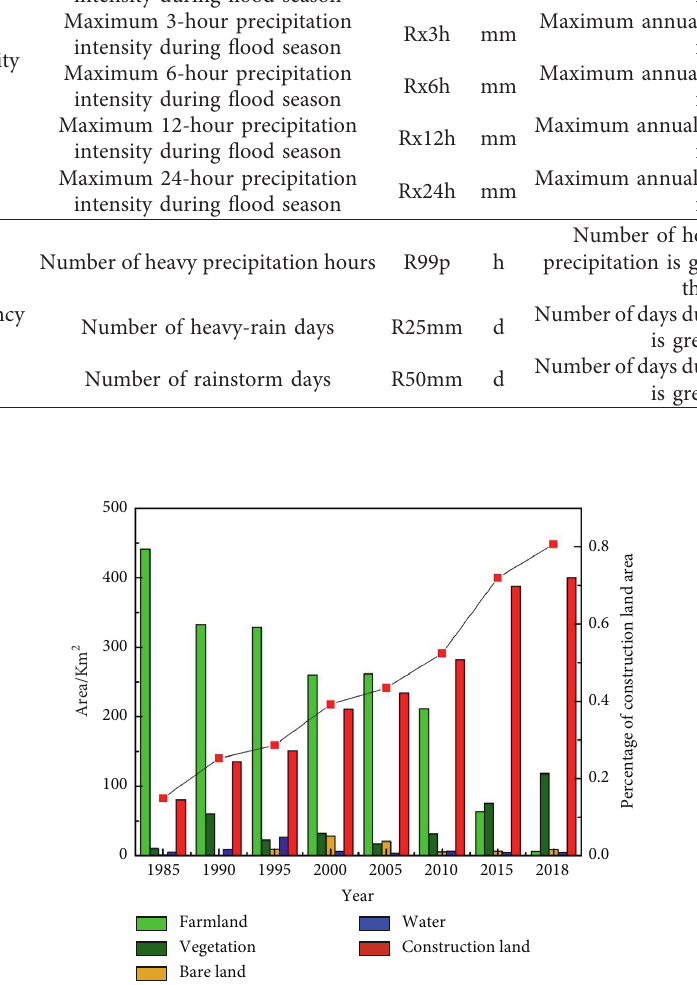
Figure 2: Variations in land use and coverage area in the central urban area of the study